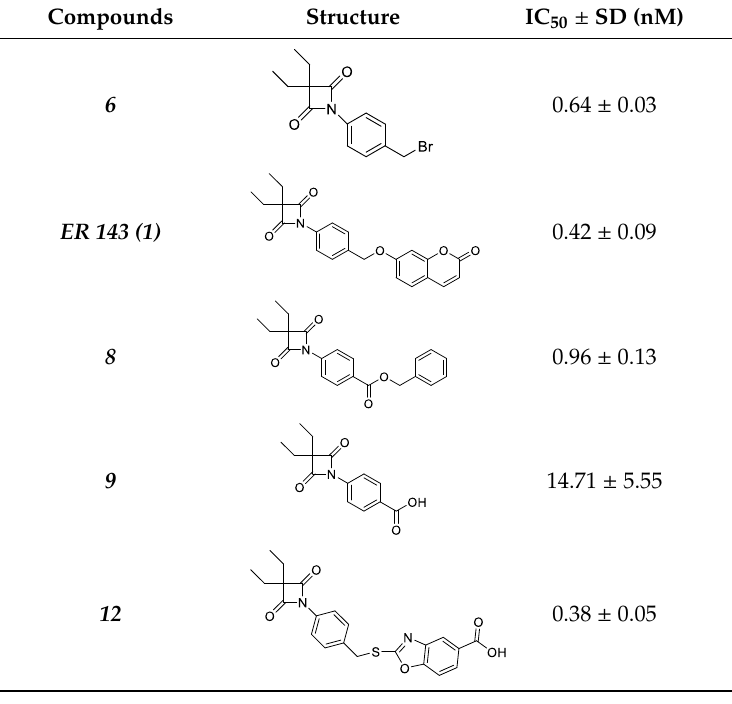
Table 2. Enzymatic inhibition assays.